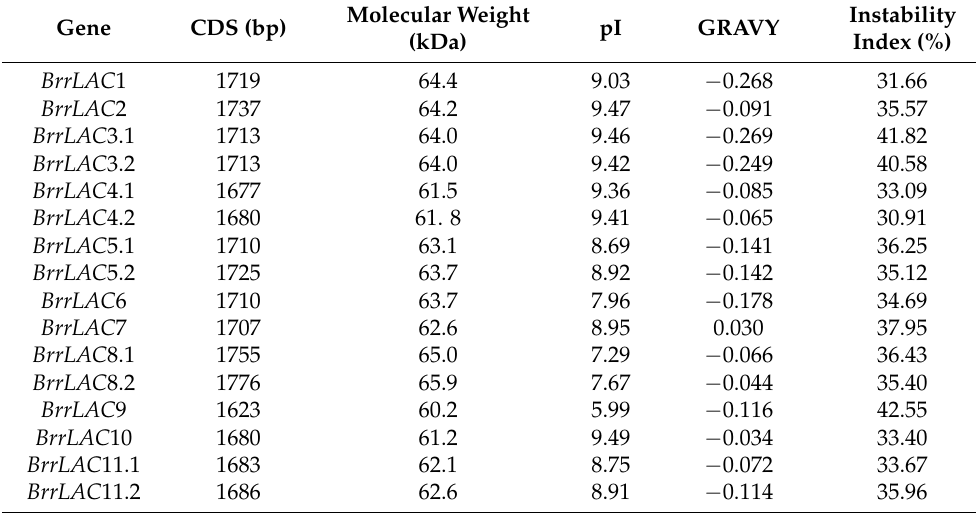
Figure 1. Changes of hypocotyl vascular structure during early development stage in turnip and Chinese cabbage. The free-hand sections of hypocotyl were made from 4–32-day-old seedlings and stained with Safranin O-Fast Green. Bar = 15 µ m. Table 1. Physical and chemical properties of the predicted proteins of BrrLAC